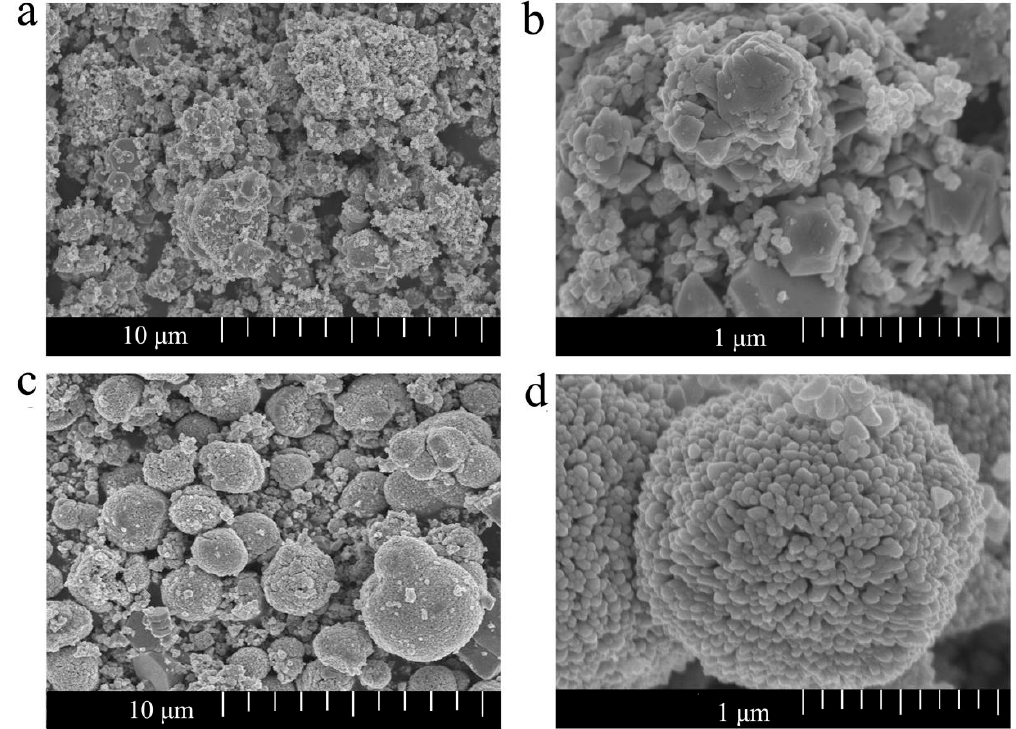
Figure 3. SEM images of ( a , b ) undoped ZnO and ( c , d ) Mg-doped ZnO (1.5 mol%) nanostructures at different multiple resolutions.